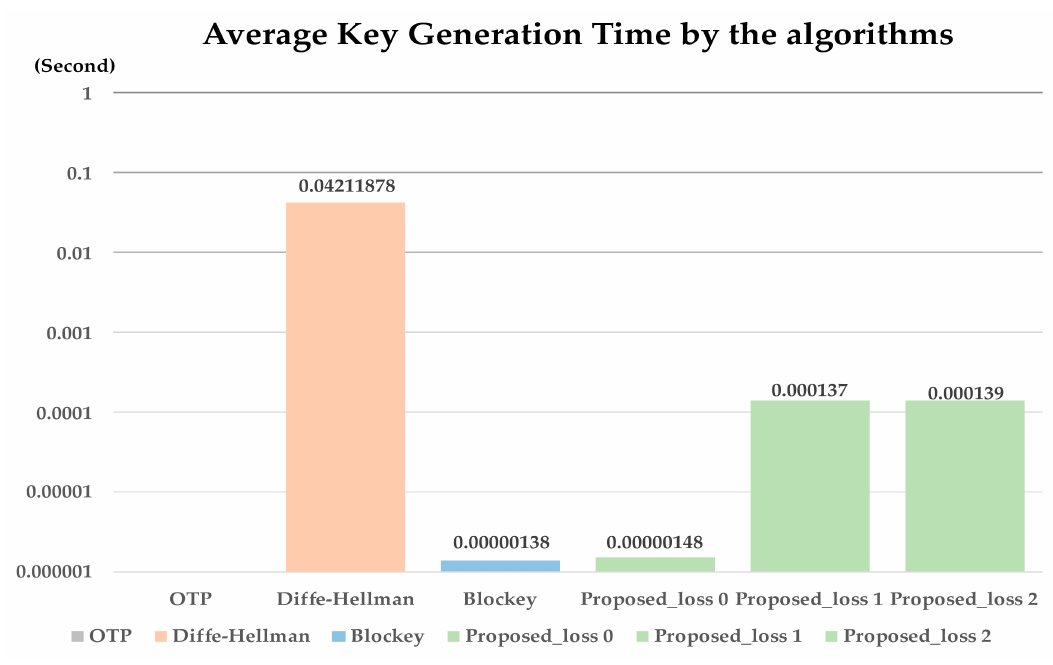
Figure 12. Experiment result of Section 4.2.4.